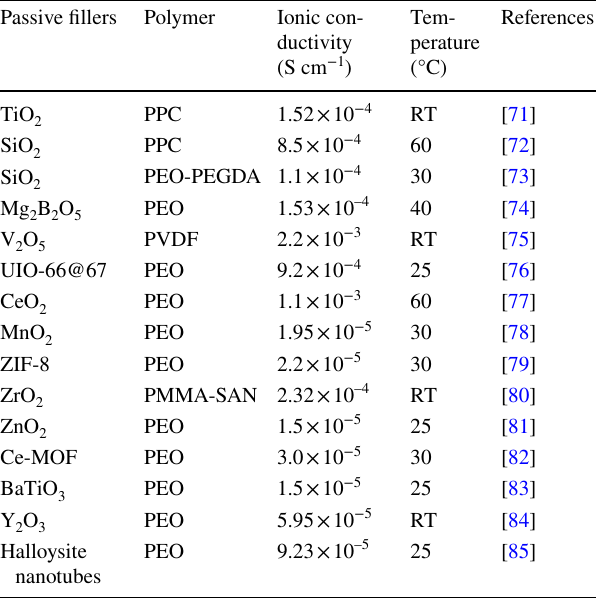
Table 2 CPEs incorporated with passive fillers Passive